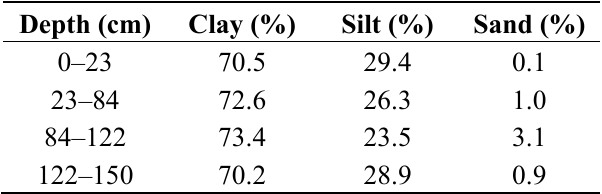
Table 1. Some physical properties of the